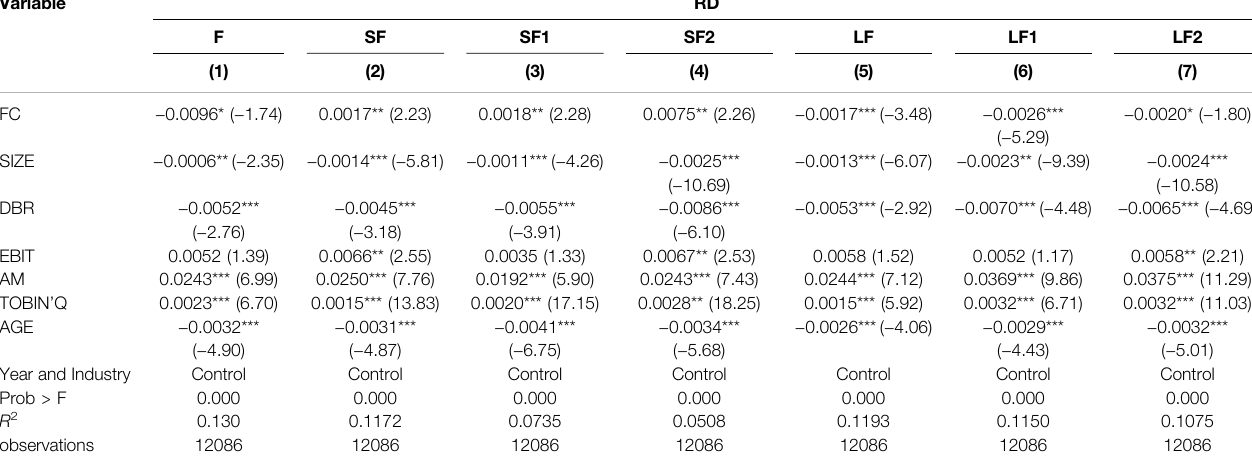
TABLE 4 | Regression results of the relationship between different forms of fi nancialization and fi rm innovation. Variable